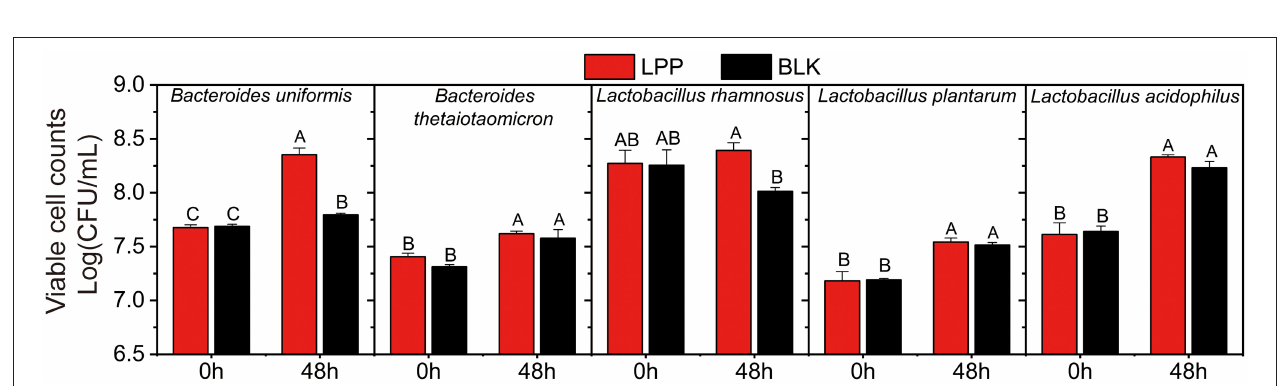
FIGURE 2 | The viable cell counts of five gut microbial strains before and after fermentation (at 0 and 48h) with LPP. BLK group was fermented with PBS solution. Bars with no letter in common are significantly different ( p < 0.05).